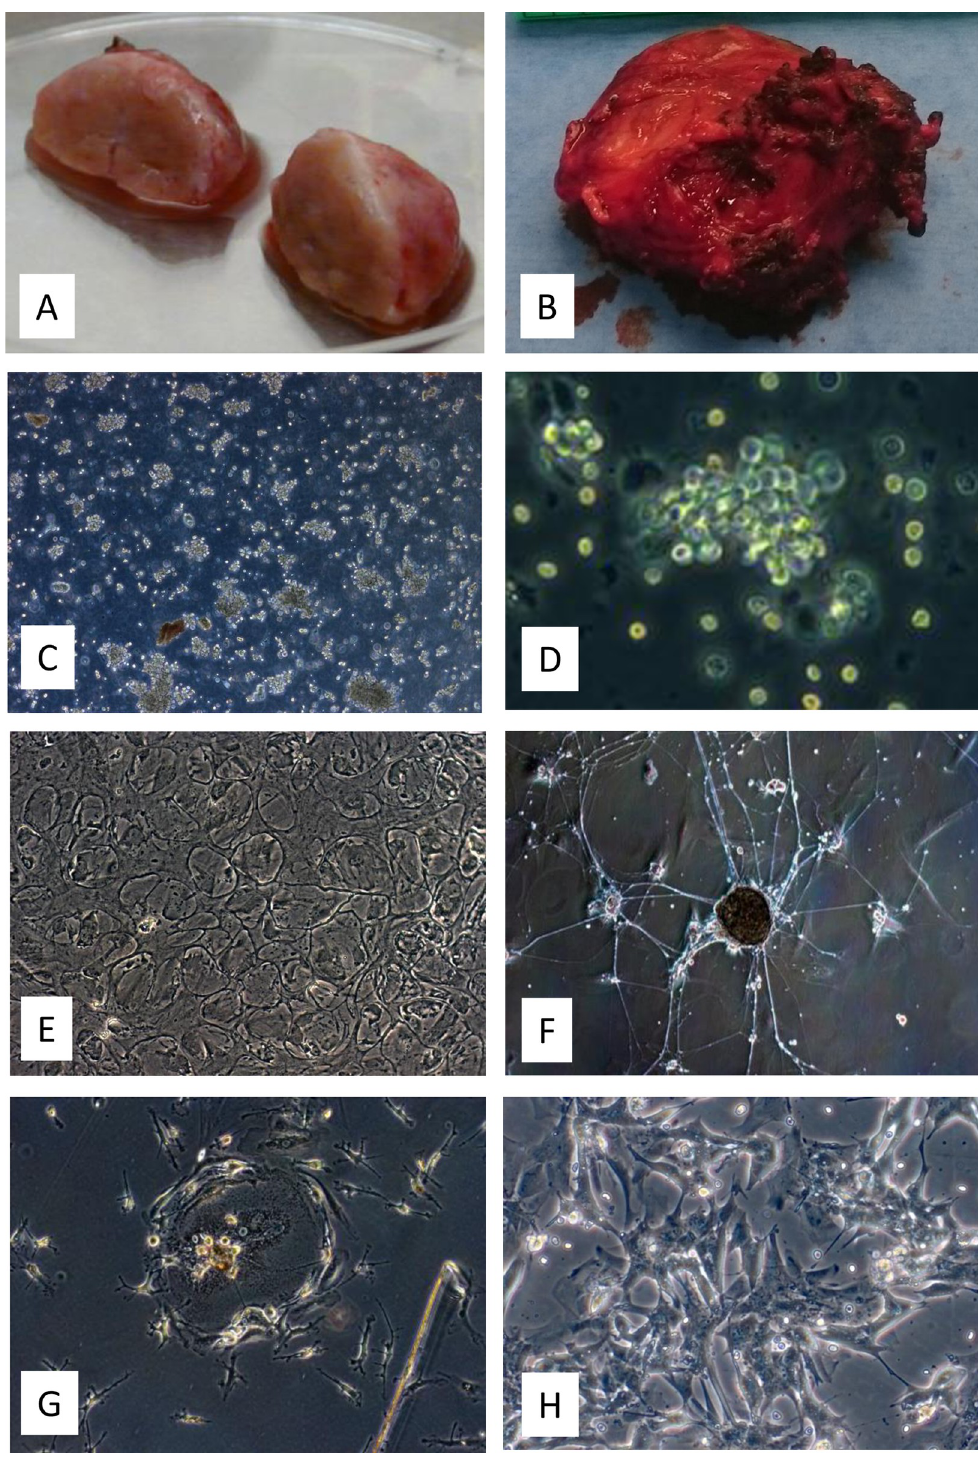
Fig 3. Surgically excised PPGLs vary considerably in their gross appearance. Pliant, highly vascular tumours (A) digest readily, whereas firm, dark tumours (B) generally require more rigorous treatment to release tumour cells. Digested tissue features single cells and large and small groups of tumour cells (C, Tu57_10x obj. phase contrast). Tumour-derived cells show an irregular light halo around a darker central area, in contrast to the ‘doughnut’ appearance of erythrocytes (D, Tu57_40x obj. phase contrast). Long-term cultures occasionally develop areas that show roughly circular lattice